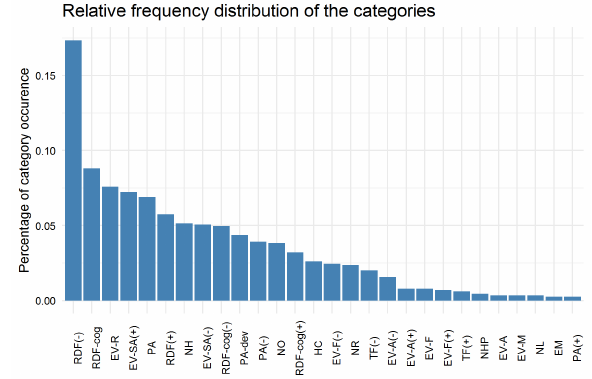
Figure 6: Relative frequency distribution of the categories across conditions.